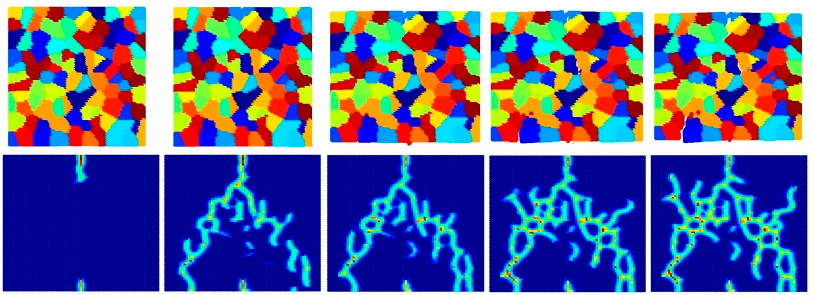
Figure 14. Fracture pattern of polycrystal when β = 0.5 with 74 × 74 particles. From left to right: time = 1.5 μ s, 2.0 μ s, 2.5 μ s, 3.0 μ s, and 3.5 μ s, respectively.